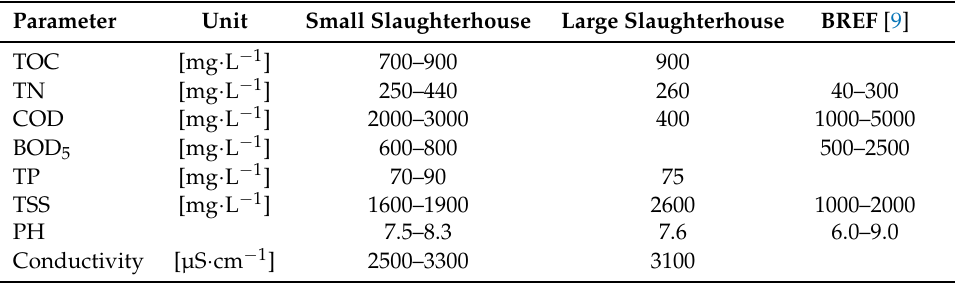
Table 2. Slaughterhouse wastewater characteristics.